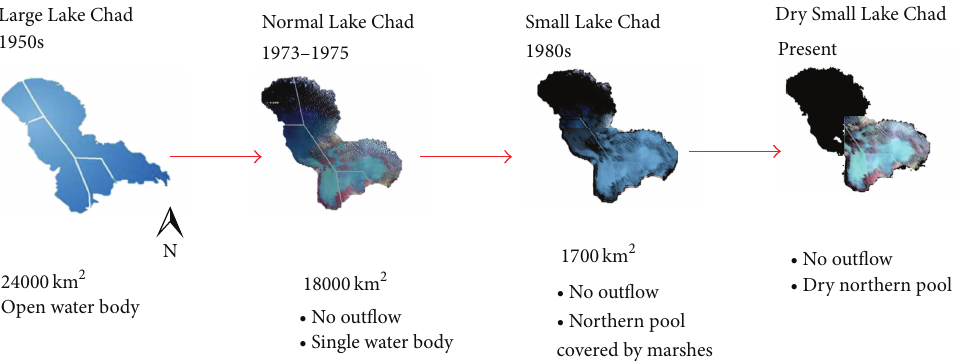
Figure 1: Schematics of the state of Lake Chad (modified from Landsat 5 images; courtesy of NASA).